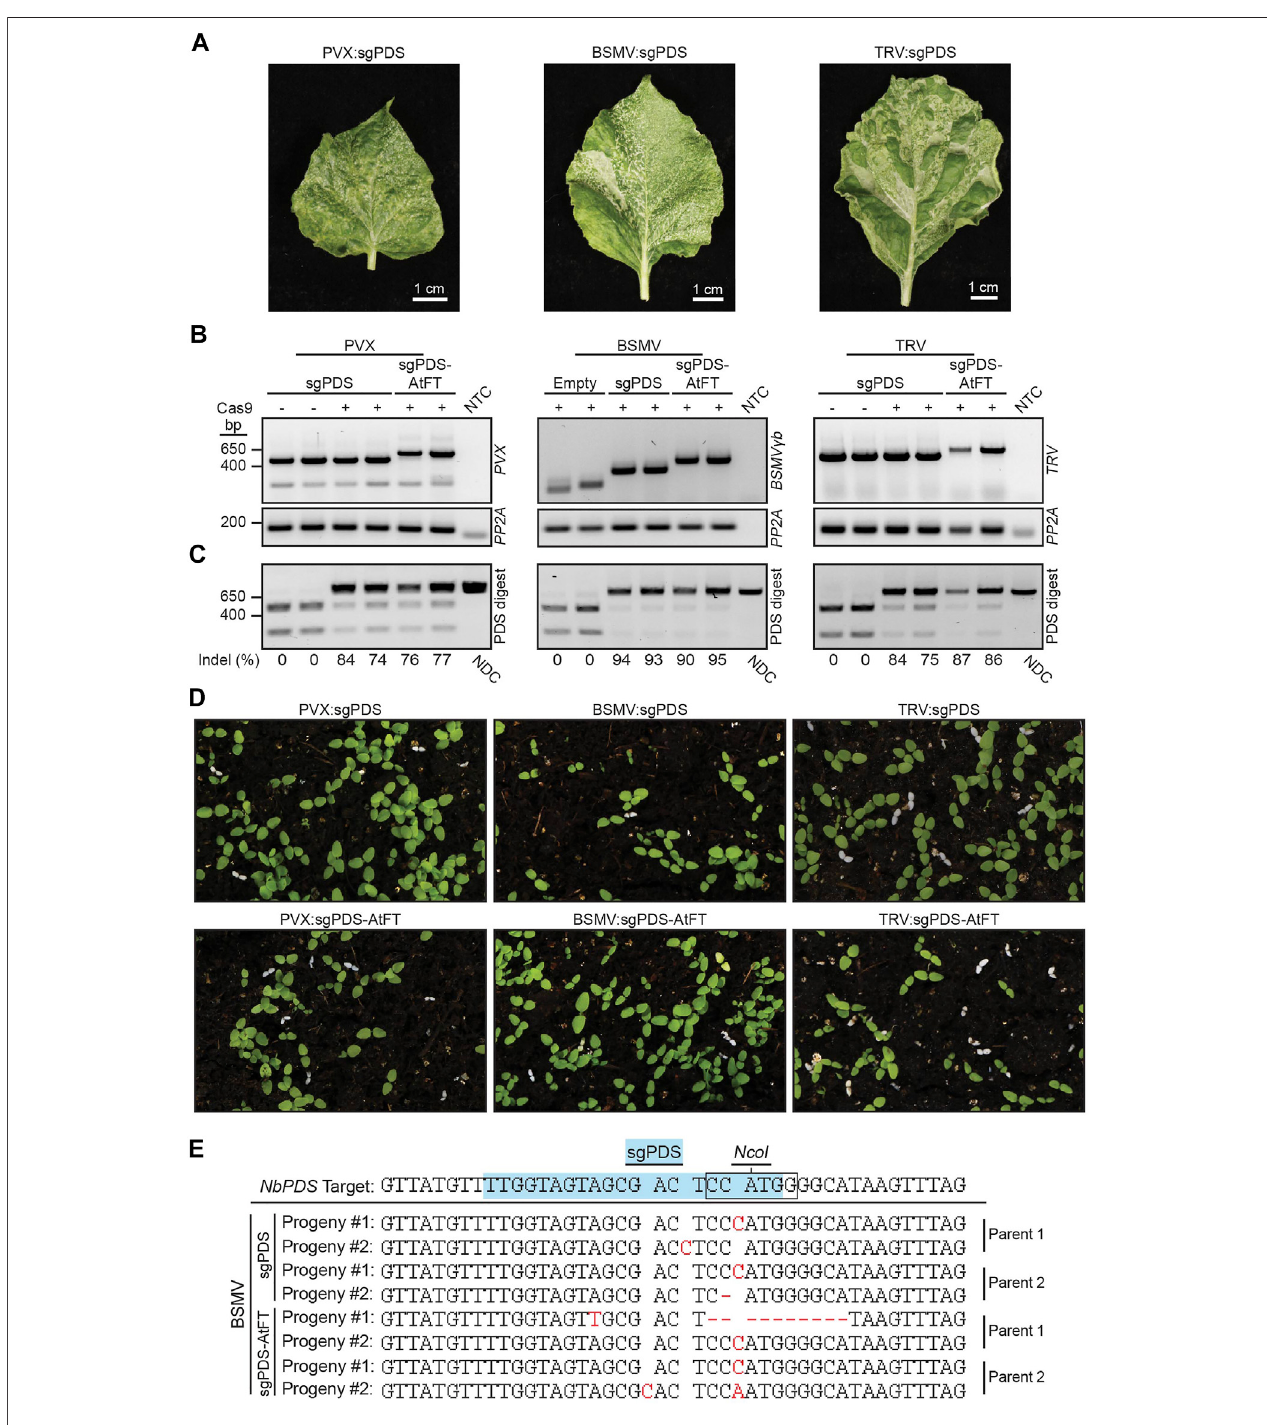
FIGURE3| Somaticandgermlinemutationsin NbPDS inducedbyBSMV,PVXorTRVcontainingasgRNAaloneorfusedtotruncatedAtFT. (A) Systemicleavesof Cas9 N. benthamiana plants infected with BSMV:sgNbPDS, PVX:sgNbPDS, and TRV:sgNbPDS. (B) RT-PCR ampli fi cation of the indicated virus spanning sgRNA insertion sites from systemic parental leaf tissue. NbPP2A was used as an internal control. (C) NbPDS amplicons from systemic leaf DNA of plants infected with the indicated viral constructs following digestion with Nco I. Digestion of unedited NbPDS amplicons generates two fragments migrating to 256 and 541 bp. Non- digested fragments represent NbPDS editing due to disruption of the Nco I site, and have similar size to the non-digested control (NDC) amplicon (797 bp). For PVX and TRV, PVX:sgPDS and TRV:sgPDS infection of wild type N. benthamiana represents the negative control for somatic mutations. For BSMV experiments, the negative control for somatic mutations was Cas9 N. benthamiana infected with BSMV with no sgPDS. (D) Representative images of progeny from NbCas9 plants infected with